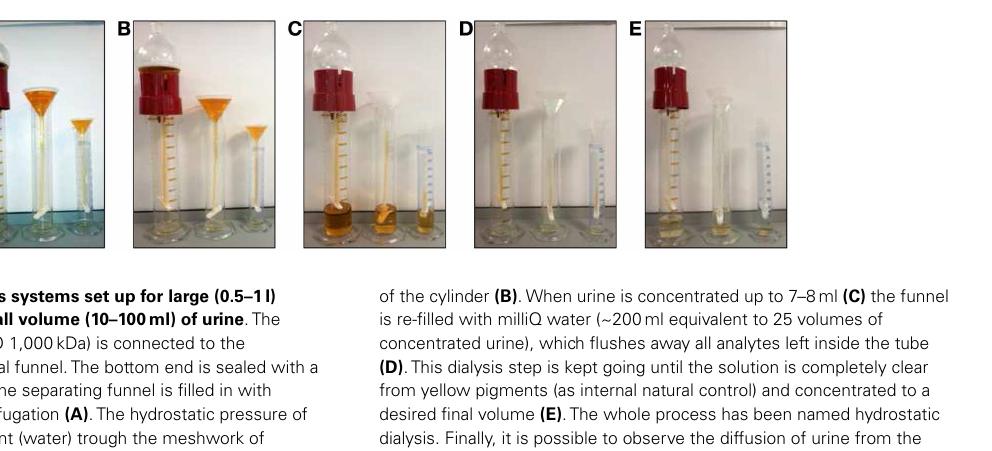
FIGURE 3 | Hydrostatic dialysis systems set up for large (0.5–1l) medium (200–600ml) and small volume (10–100ml) of urine .The dialysis membrane tube (MWCO 1,000kDa) is connected to the separating funnel and/or a normal funnel.The bottom end is sealed with a universal dialysis tube closure.The separating funnel is filled in with supernatant from 2,000 g centrifugation (A) .The hydrostatic pressure of urine in funnel pushes the solvent (water) trough the meshwork of dialysis membrane and liquid below the MWCO, which fells to the bottom